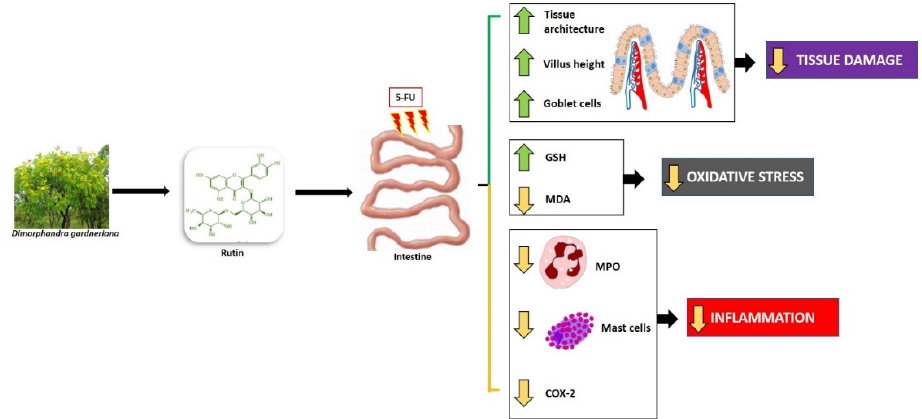
Figure 14. Hypothetical chemopreventive effect of RUT in intestinal mucositis induced by 5-FU. RUT prevents intestinal inflammation by inhibiting MDA, MPO, COX-2, oxidative stress, mastocytosis. RUT also stimulates increased villi and increased levels of the antioxidant GSH. RUT, Rutin; COX-2, Cyclooxygenase 2; MDA, Malondialdehyde; MPO, Myeloperoxidase; GSH, Reduced Glutathione. Green arrows (stimulate / increase), yellow arrows